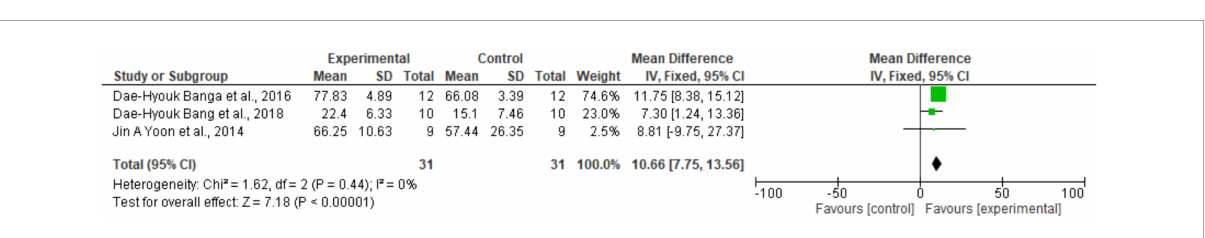
FIGURE5 Forest Plot of the activity/participation assessed by the test Modified Barthel Index. SD, standard deviation; CI, confidence